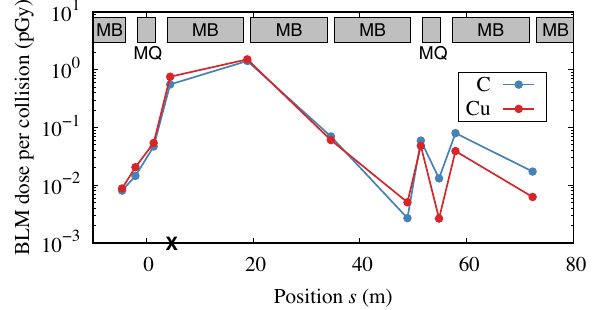
FIG. 4. Comparison of simulated BLM dose patterns for beam collisions with dust particles of different composition. The proton beam energy was 6.5 TeV. The dose is given per proton-nucleus collision. The assumed loss location is indicated by a cross on the s axis. The beam direction is from the left to the right. The statistical error of the simulations is less than 3% for the highest signal, but can be as large as few 100% for the smallest signals. The data points are connected by lines to guide the eye.